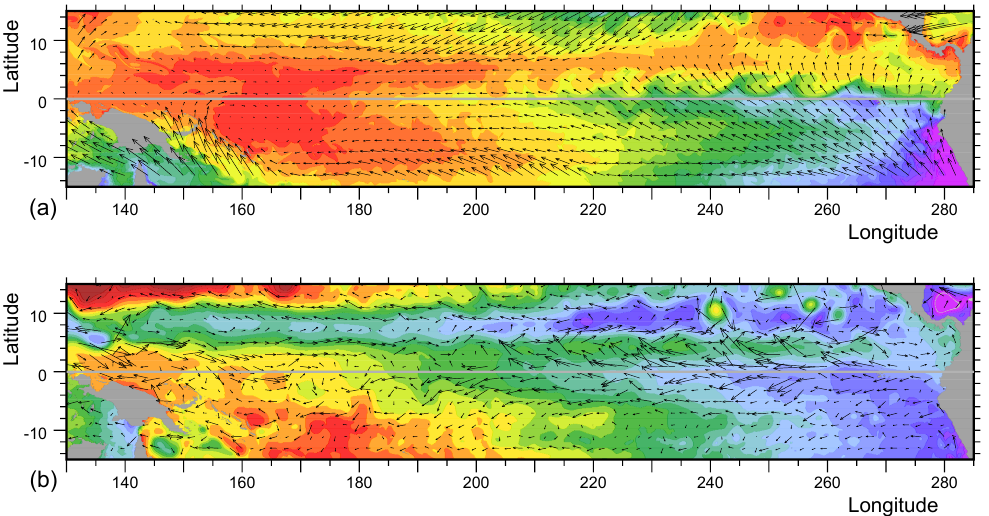
Figure 23. (a) Surface temperature and wind stress vectors. (b) SSH and velocity vectors are from the 29 June 1982 archive dataset. Colours and vector scales are as in Fig.